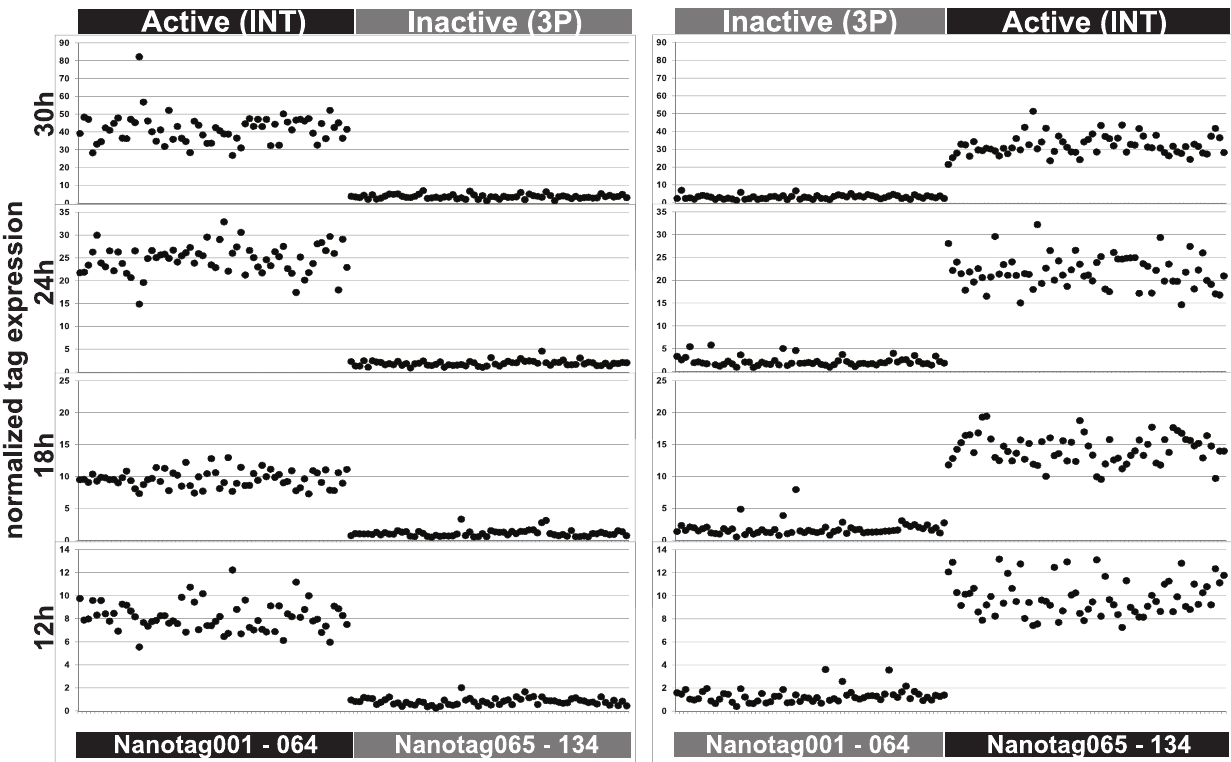
Figure 2. Variations among 130 Nanotags driven by the same CRM at four time points. Right panels show expression levels of the first half of Nanotag vectors driven by the same known active CRM, the nodal INT [14] and the other half driven by the same known inactive DNA fragment, the nodal 3P [14]. The Nanotag vector and driver pairs were swapped in left panels. Expressions of Nanotags were normalized to the numbers of DNA copies incorporated into the sea urchin genome. Note that four Nanotags 082, 083, 125, and 133 are missing due to problems in manufacturing probes.